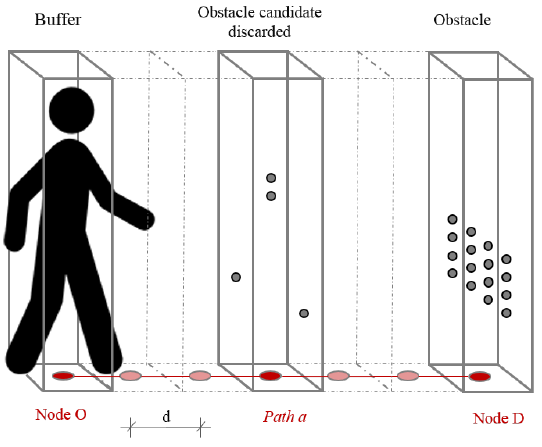
Figure 3: Schema of the obstacle detection